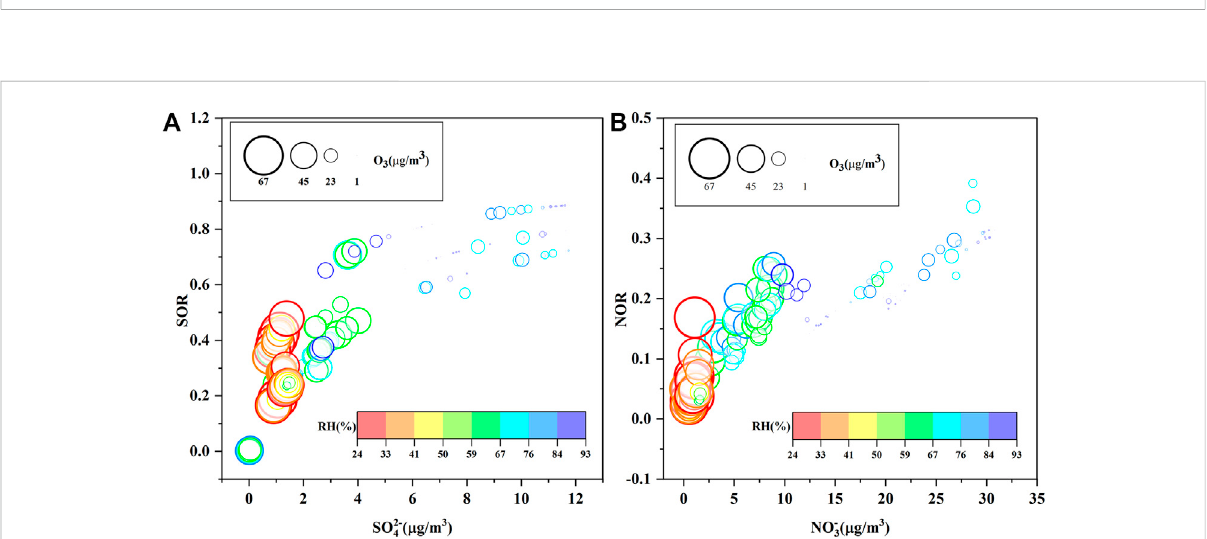
FIGURE 9 (A) Relationship between SOR and SO 4 2- colored by RH and (B) relationship between NOR and NO 3 − colored by RH; the circle size represents the